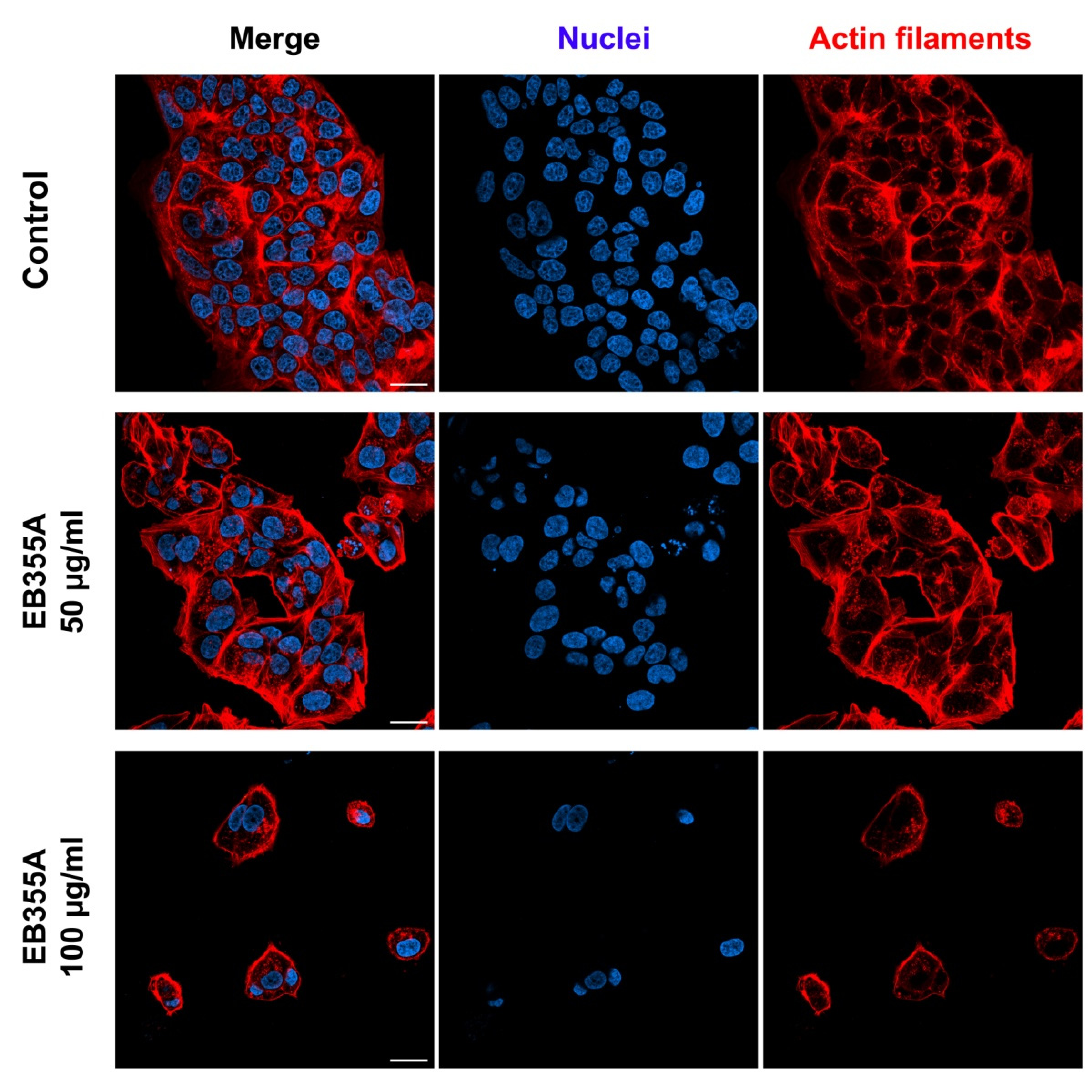
Figure 5. Confocal microscopy imaging of MCF-7 cells treated with the new betulin derivative EB355A for 72 h. Photographs present merged images and separated channels for nuclei and actin filaments. Scale bar shows 25 µM.